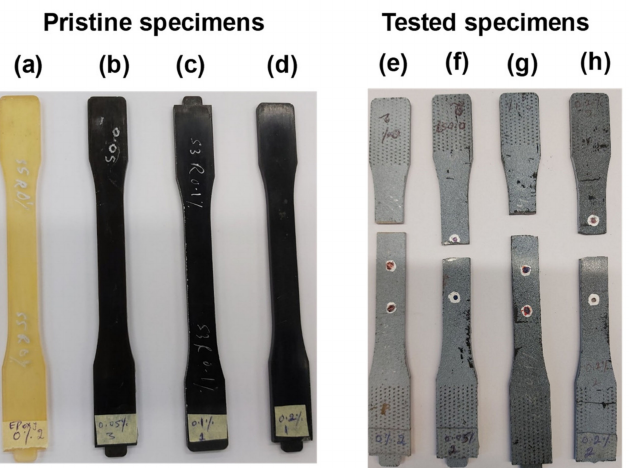
Figure 4. Typical different weight percentages of GO-reinforced epoxy specimens: 0% ( a , e ), 0.05% ( b , f ), 0.1% ( c , g ), and 0.2% ( d , h ).